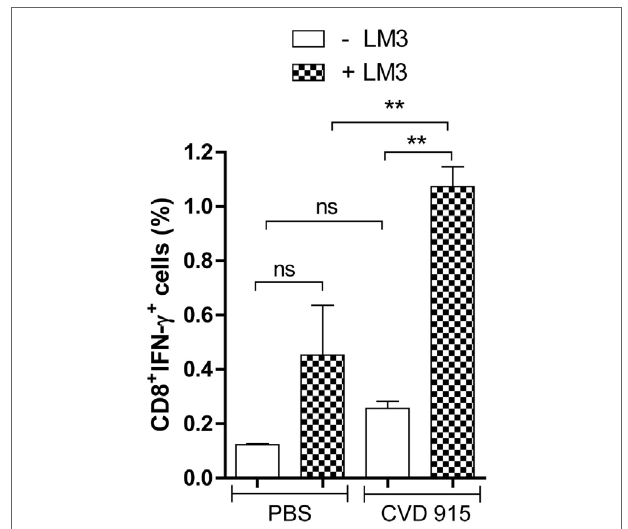
FigUre 5 | Tumor-specific iFn- γ -producing cD8 + cells in liver- draining lymph nodes (lDln) after oral Salmonella -based treatment . Twenty-one days after treatment with CVD 915 or PBS, LDLN from tumor-bearing mice were removed. Samples from three animals per group were pooled. LDLN cells were stimulated or not with LM3 tumor cells for 96 h. Then, CD8 + surface expression and intracellular IFN- γ production were measured by flow cytometry as indicated in Section “Materials and Methods.” Bars represent the mean ± SEM percentage of CD8 + IFN- γ + T cells per culture of LDLN cells. ** p < 0.01 ( n = 6–10).